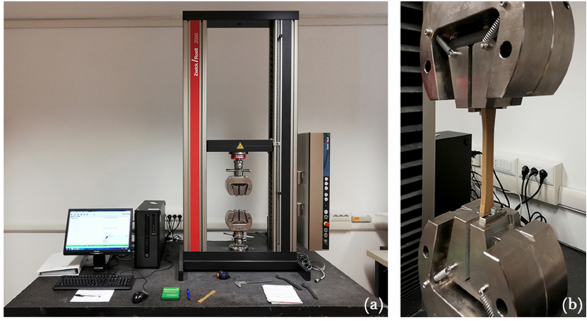
Figure 1: Experimental set-up: (a) ZWICK/Roell-Z050 equipment, (b) positioning of the specimens during the tensile